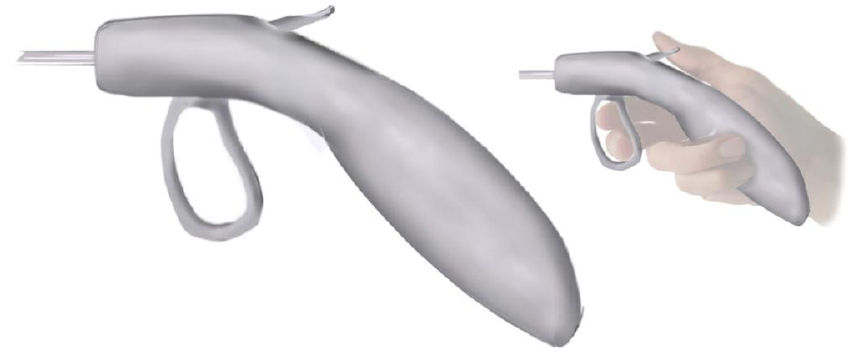
Figure 2. The laparoscopic tool handle developed in the ERGOLAP project.